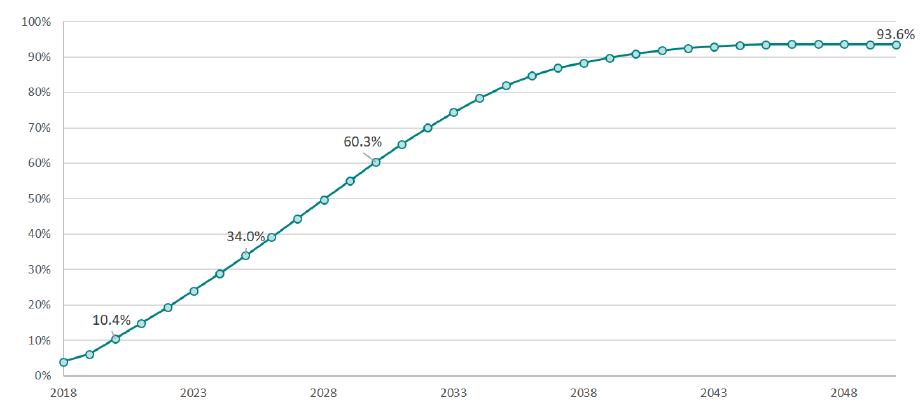
Figure 2. The automatic emergency braking (AEB) penetration rate through 2050 in China.